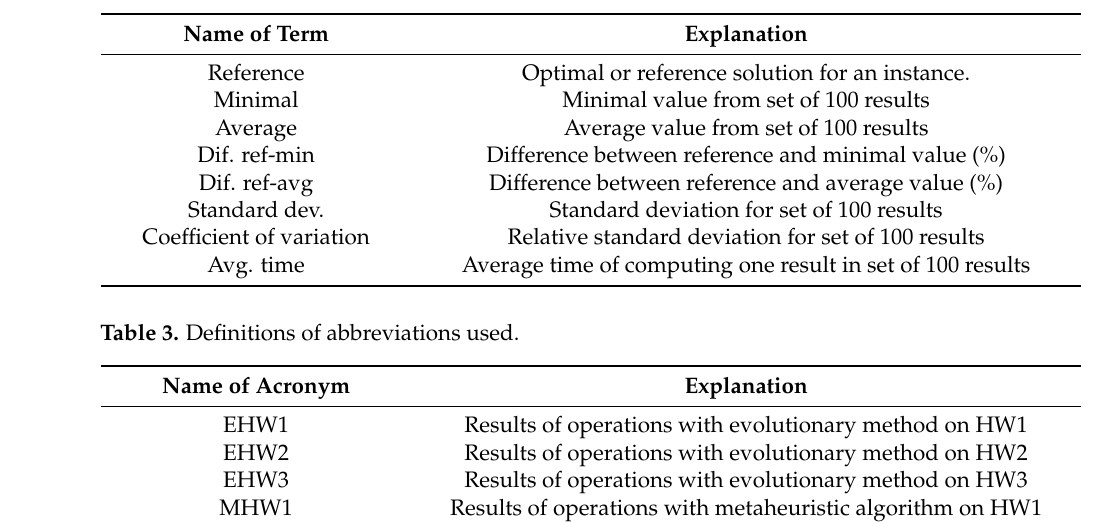
Table 2. Definitions of terms used.